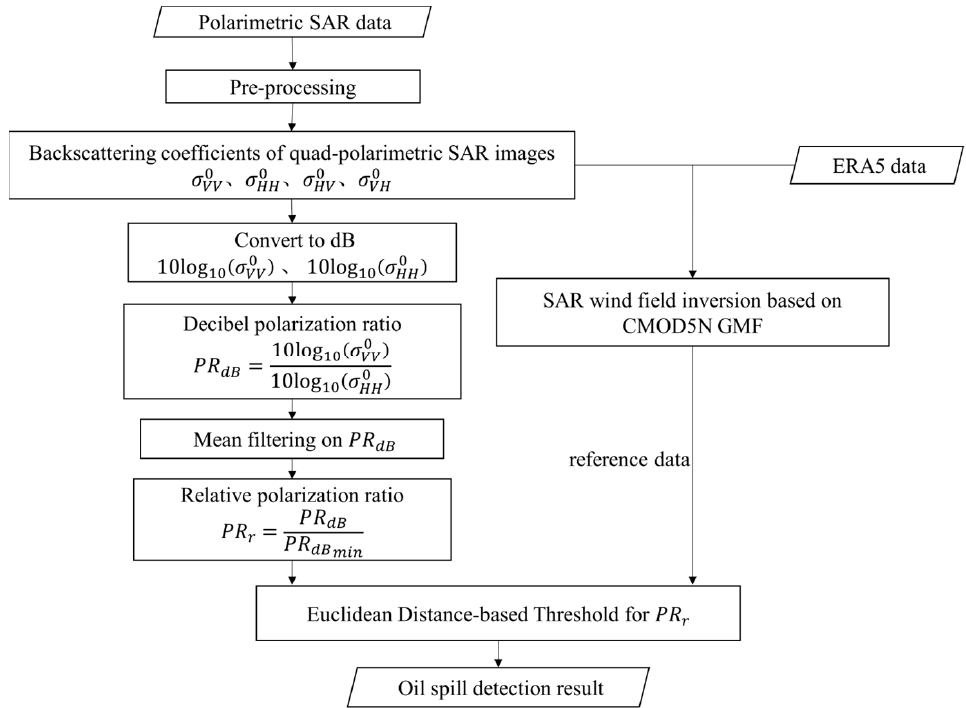
Figure 1. The fl ow chart for the proposed method. Figure 1. The flow chart for the proposed